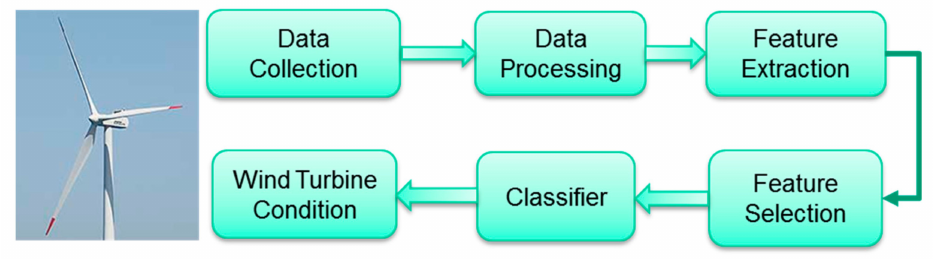
Figure 1. Scheme of wind turbine fault